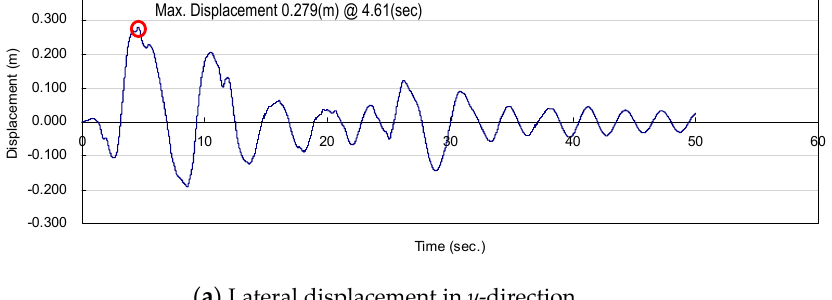
Figure 15. Lateral displacement history of each wall component (El Centro, α = 1.3, β = 1.0).